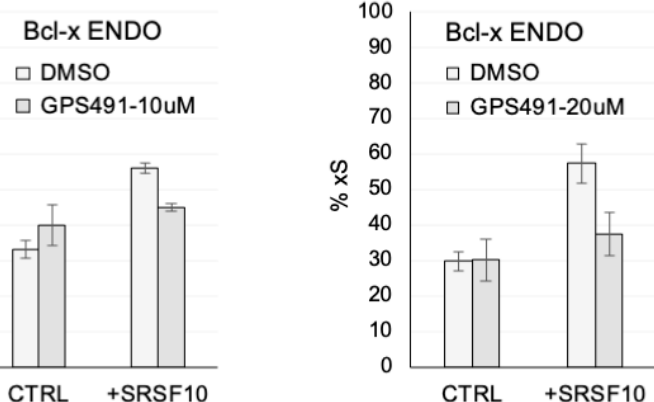
Figure 7. GPS491 alters the function of only a subset of SR proteins. ( a ) Map depicting the Bcl-x pre-mRNA and the Bcl-x minigene 2.13 as well as the position of the primers used for RT-PCR. ( b ) Map of the endogenous Bcl-x gene and spliced products Bcl-xS and Bcl-xL. Positions of primers for RT-PCR are indicated. ( c ) HEK 293 cells were transfected with Bcl-x reporter along with plasmids expressing the indicated SR proteins, followed by treatment with DMSO or 10 µM GPS491. After 48 h, total RNA was isolated and RT-PCR was performed. The relative abundance of the xL and xS products was determined following fractionation on PAGE gels. ( d ) Assays were repeated with overexpression of SRSF10 in the presence of DMSO and 10 or 20 µM GPS491, evaluating the effect on alternative splicing of the endogenous Bcl-x gene (Bcl-x ENDO). Representative gel images are provided in Supplementary Figure